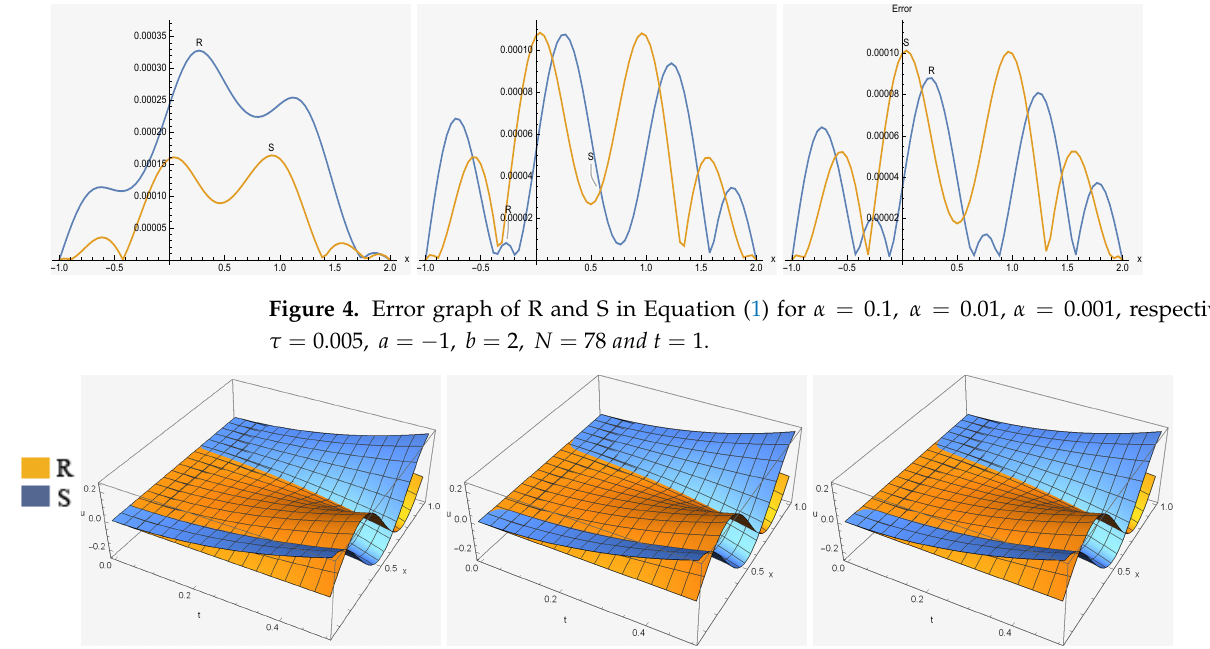
Figure 5. Computed approximation solutions of R and S in Equation (1) for α = 0.6, α = 0.2, α = 0.01, respectively, τ = 0.0025, a = 0, b = 1, N = 40 and t =